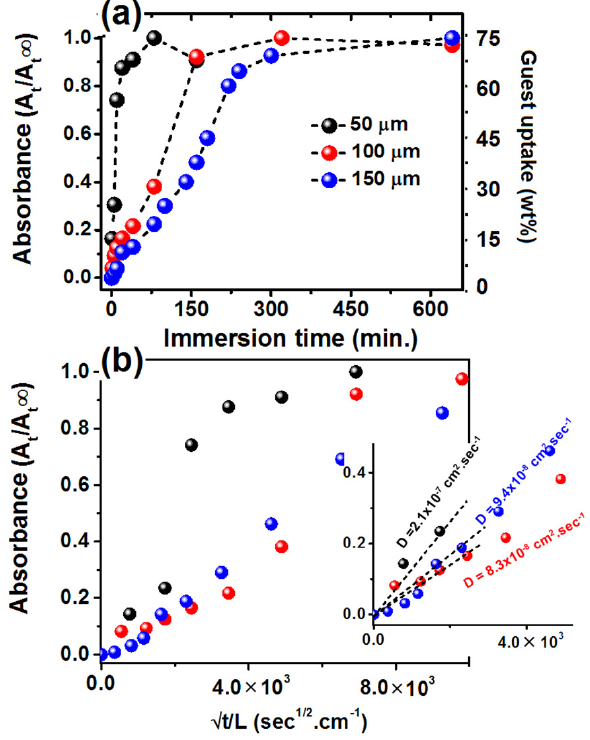
Figure 3. BE guest sorption kinetics at room temperature (~20 ◦ C) in PPO amorphous films of different thickness ( a ) and corresponding Fick’s plots ( b ). The weight uptake for the 100 µ m film is shown on the right scale. The inset in ( b ) shows enlarged Fick’s plot, which have been used to evaluate diffusivity values of BE in amorphous PPO films with different thickness.